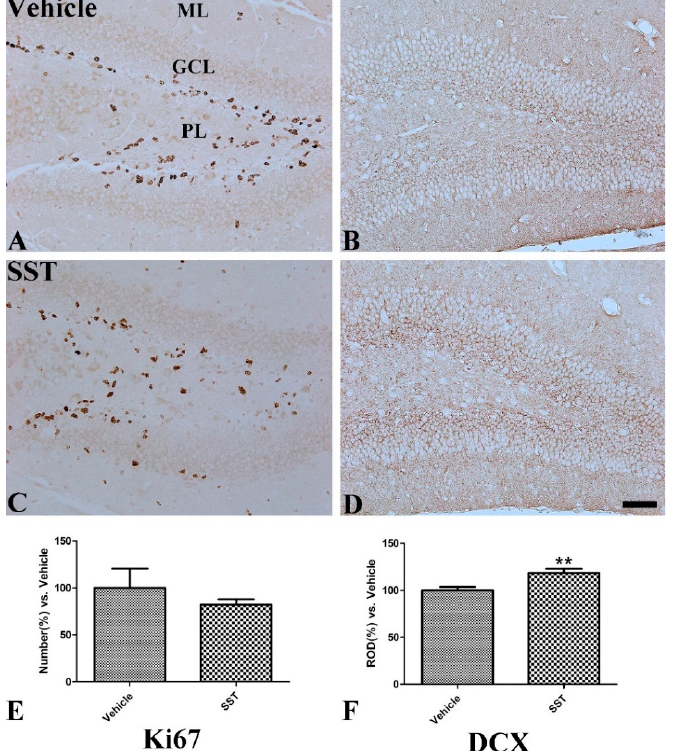
Figure 6. Immunohistochemical staining for Ki67 and DCX in the mouse dentate gyrus of the vehi- cle- ( A , B ) and somatostatin- (SST, ( C , D )) treated groups. Scale bar = 50 µm. ( E ): The relative number of Ki67-positive neurons per section in the dentate gyrus of the vehicle- and SST-treated groups ( F ): The relative optical density of DCX-positive immunoreactivity in the dentate gyrus of the vehicle- and SST-treated groups, GCL granule cell layer; ML molecular layer; PL polymorphic layer, n = 5 per group; ** p < 0.01, significantly different from the vehicle-treated group. All data are represented as the mean ± standard error of the